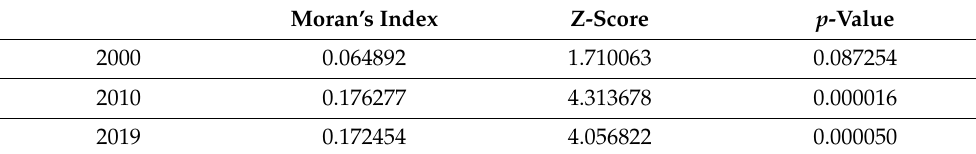
Table 4. Global Spatial Autocorrelation of Economic Security in the Qinghai–Tibet